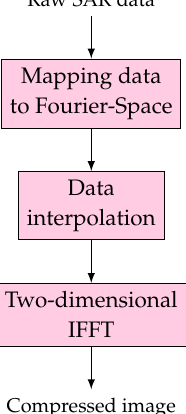
Figure 7. Block diagram of the polar format